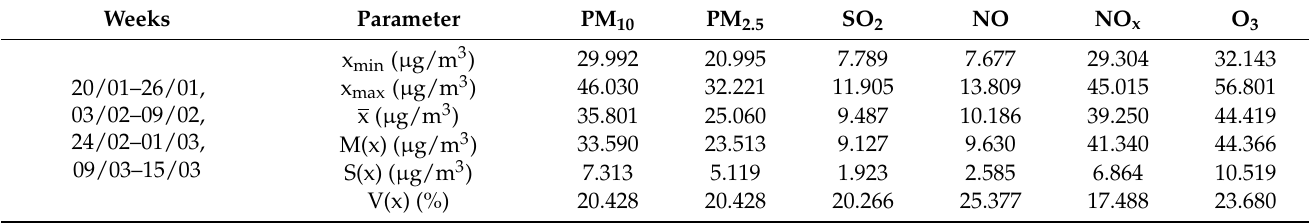
Table 6. Average measures and measures of relative variability for the group no. 3.